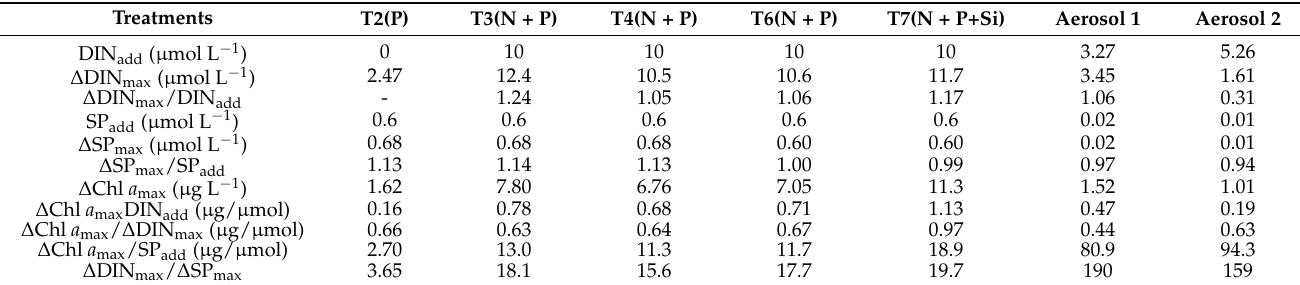
Table 2. Comparison of nutrient consumption, Chl a , and their ratios for different treatments of the bioassay experiments in 2012 and 2014.